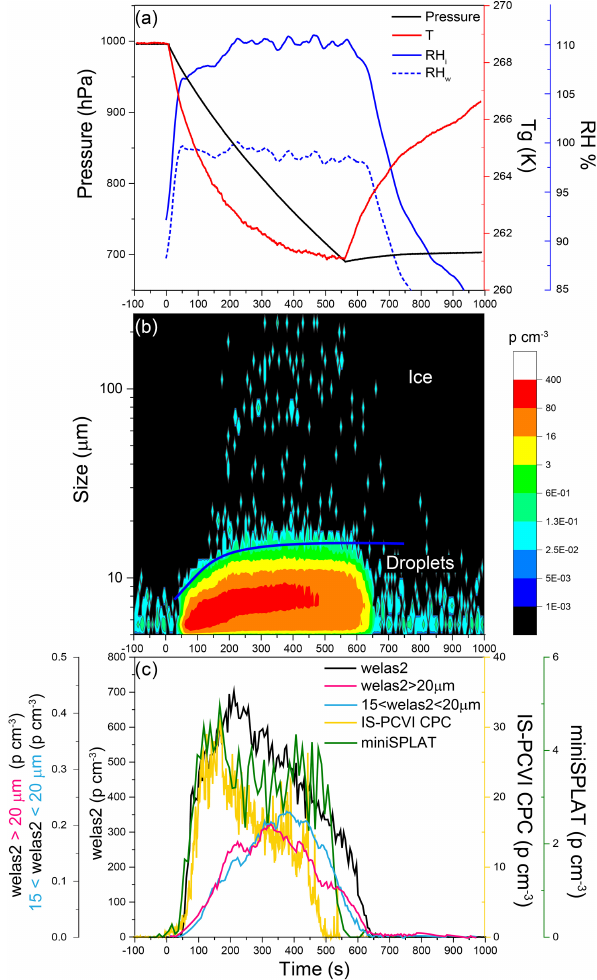
Figure 13. Data from Expansion 3 with PF CGina bacteria. (a) The pressure (black) and the temperature of the gas (red) inside the AIDA chamber. The measured RH with respect to ice (RH i ) and water (RH w ) is indicated in solid and dashed blue lines, respec- tively; (b) the size distributions of the particles measured with we- las2 during the expansion. Particles smaller than ∼ 15µm are liq- uid droplets, while larger particles are ice. The IS-PCVI cut size is shown in blue. (c) The welas2-measured total particle number concentrations (black), the welas2 number concentrations of parti- cles larger than 15µm but smaller than 20µm (light blue), and the welas2 number concentrations of particles larger than 20µm (pink). The CPC- and miniSPLAT-measured number concentrations of par- ticles transmitted by the IS-PCVI are marked in yellow and green, respectively.